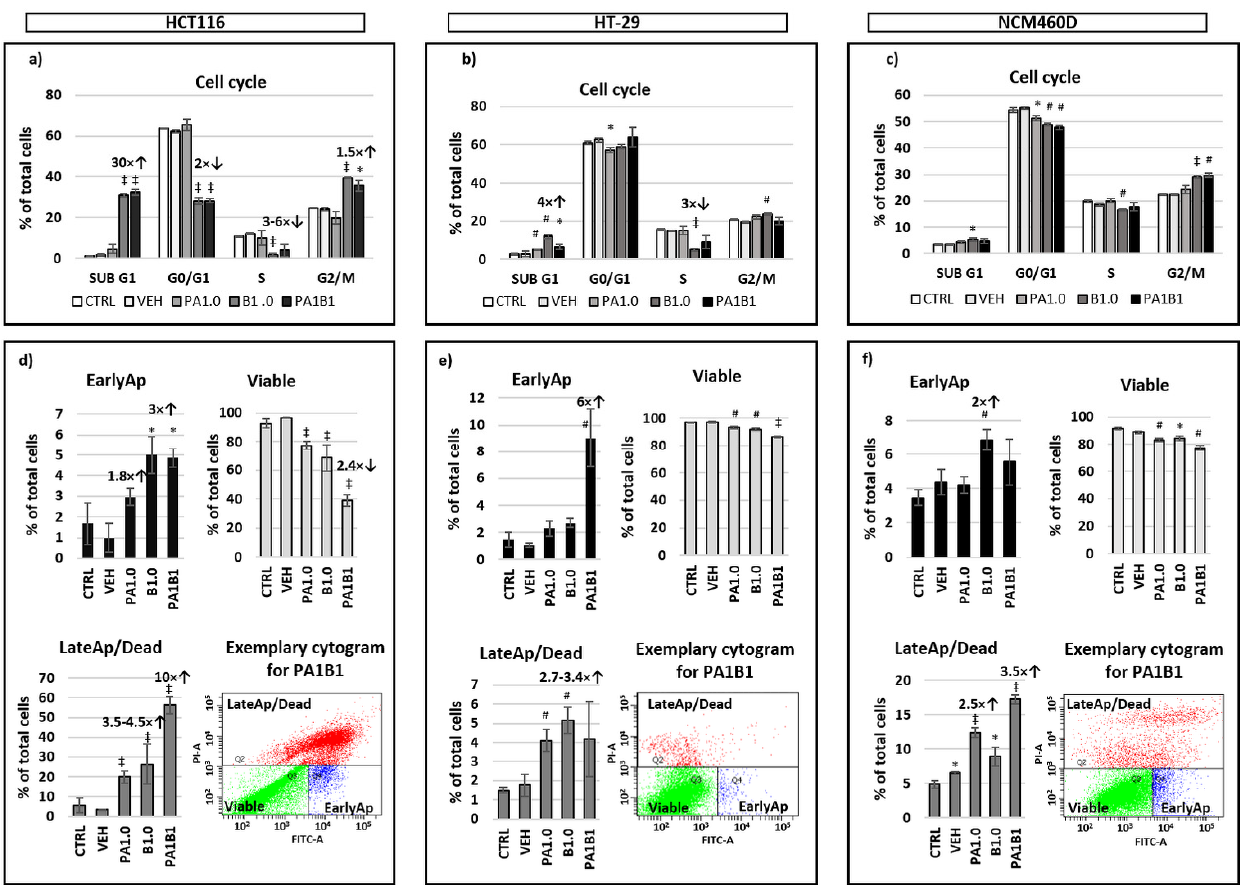
Figure 2. Results of flow cytometry analyses of HCT116, HT-29, and NCM460D cell lines. ( a – c ) cell cycle analysis of cells stained with propidium iodide. Phases of the cell cycle: SUB G1, G0/G1—cells at the stage of Gap 1 and Gap 0; S—synthesis of DNA; G2/M—cells in the phase of Gap 2 and mitosis. ( d – f ) analysis of apoptosis based on the presence of annexin V. EarlyAp—cells the at early apoptosis stage; LateAp/Dead—cells at the late apoptosis stage and dead ones. CTRL—control cells cultured without supplements; VEH—vehicle, cells cultured in medium with PBS (phytate and butyrate diluent); PA1.0—cells incubated in medium containing 1 mM phytate; B1.0—cells incubated in medium containing 1 mM butyrate; PA1B1—cell incubated in medium with both PA1.0 and B1.0. Values that differ significantly from CTRL at p < 0.05, p < 0.01, and p < 0.001 are marked with *, #, and ‡ respectively. Fold changes over the columns depict values different from CTRL, up or down arrows indicate an increase or a decrease from CTRL.